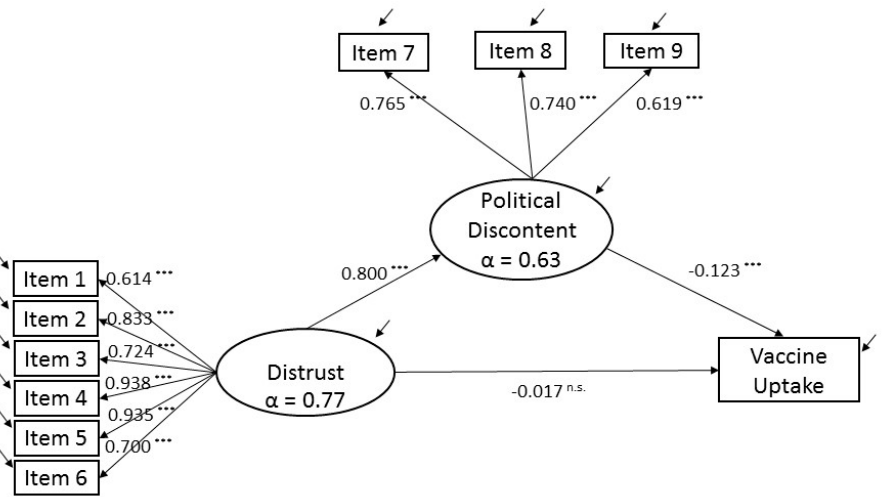
Figure 2. Structural Equation Model. Political populism mediation in the relationship between institutional distrust and vaccine uptake. Each latent variable has its associated Cronbach’s alpha ( α ). All path loads from latent variables to items are in standardized terms. *** represents p -values significant at the 1% level of significance. n.s. means no statistically significant results. Table 1. Direct, Indirect, and Total Effects of Distrust on Vaccine Uptake.